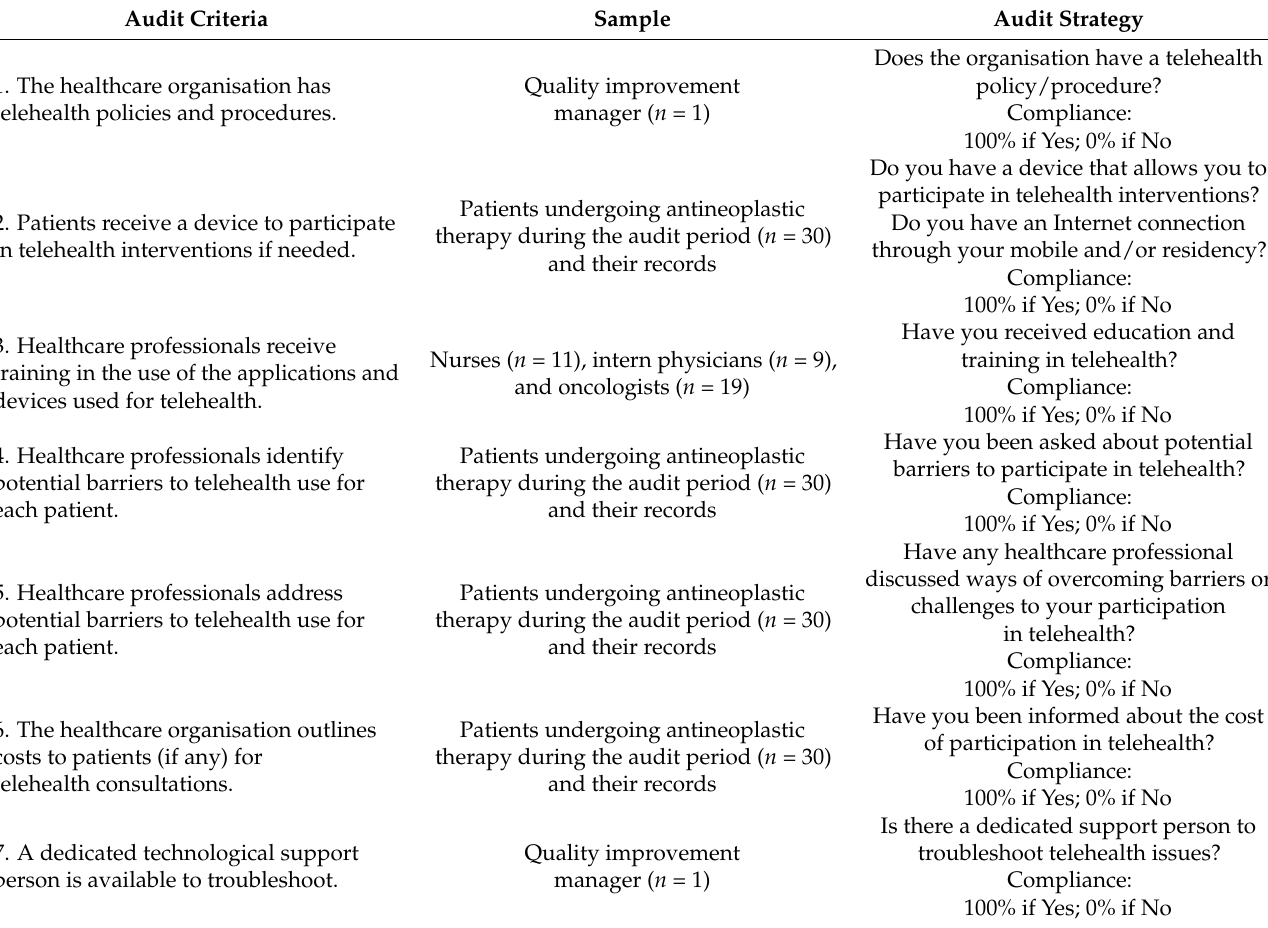
Table 1. Audit criteria, sample, and audit